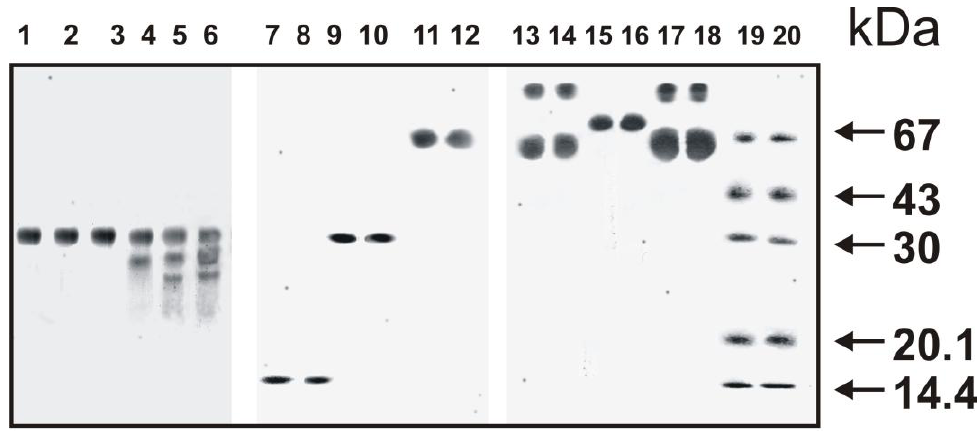
FIGURE 5. SDS-PAGE analysis of protein hydrolysis by AIDS pIgGs[37]. HIV-1 integrase (0.2 mg/ml) was incubated for 16 h in the absence (lane 1) or in the presence of 0.1 mg/ml pIgGs from two healthy donors (lanes 2 and 3) and pIgGs from two AIDS patients (lanes 4 and 5), or with 0.01 mg/ml AIDS IgGs purified on Integrase-Sepharose (6). Preparations of other proteins (0.2–0.4 mg/ml) were incubated for 16 h without (odd numbers) or with 0.05 mg/ml AIDS IgGs purified on Integrase-Sepharose (even numbers): lysozyme (7 and 8); human milk casein (9 and 10), p66 HIV-1 reverse transcriptase (11 and 12); human serum albumin (13 and 14); human milk lactoferrin (15 and 16); BSA (17 and 18); a mixture of protein molecular mass markers (19 and